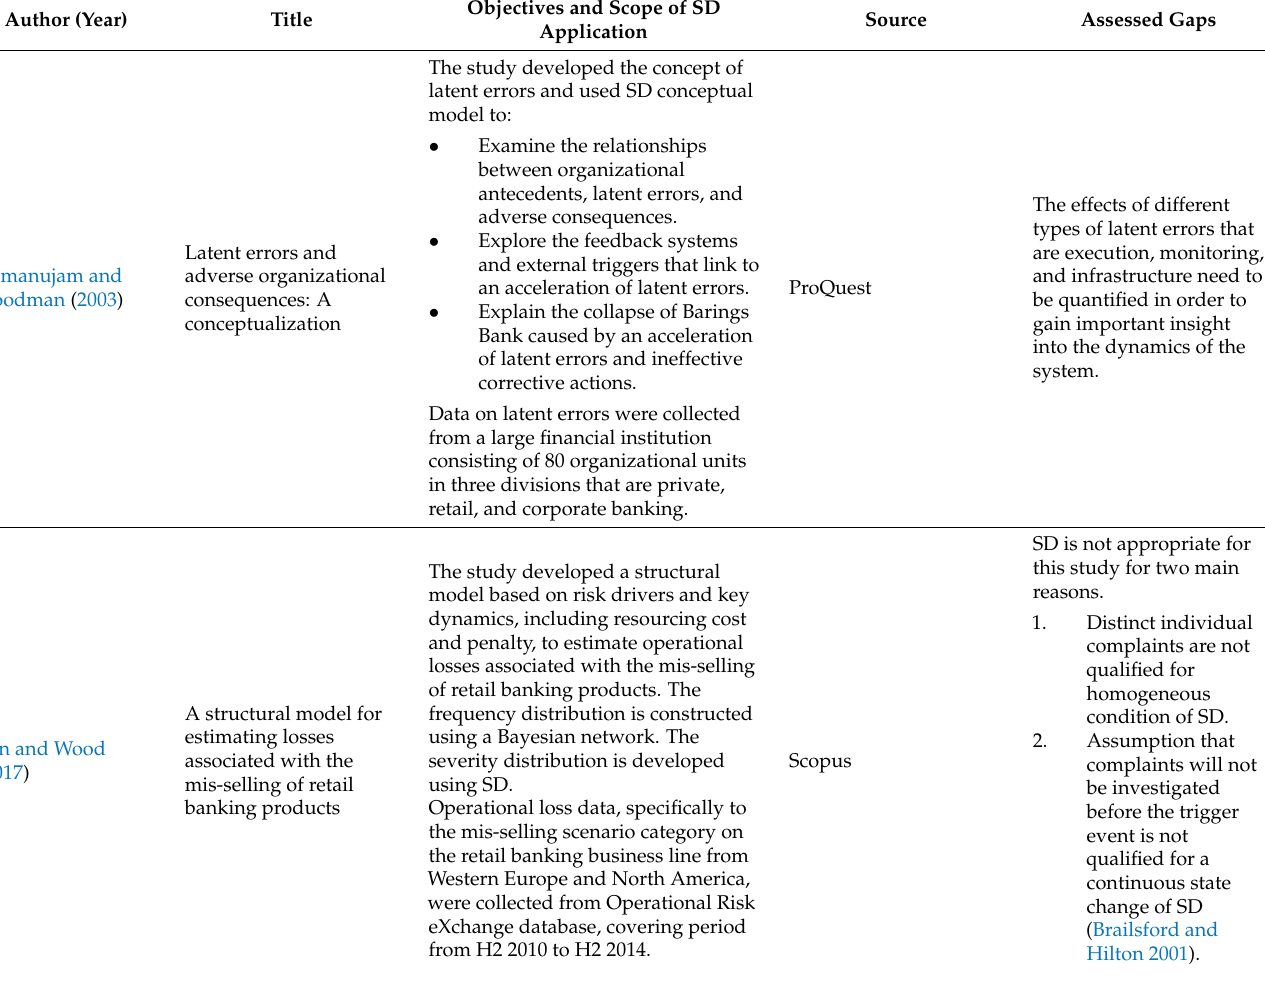
Table 4. Banking operational risk management studies applying system dynamics identified from a systematic literature